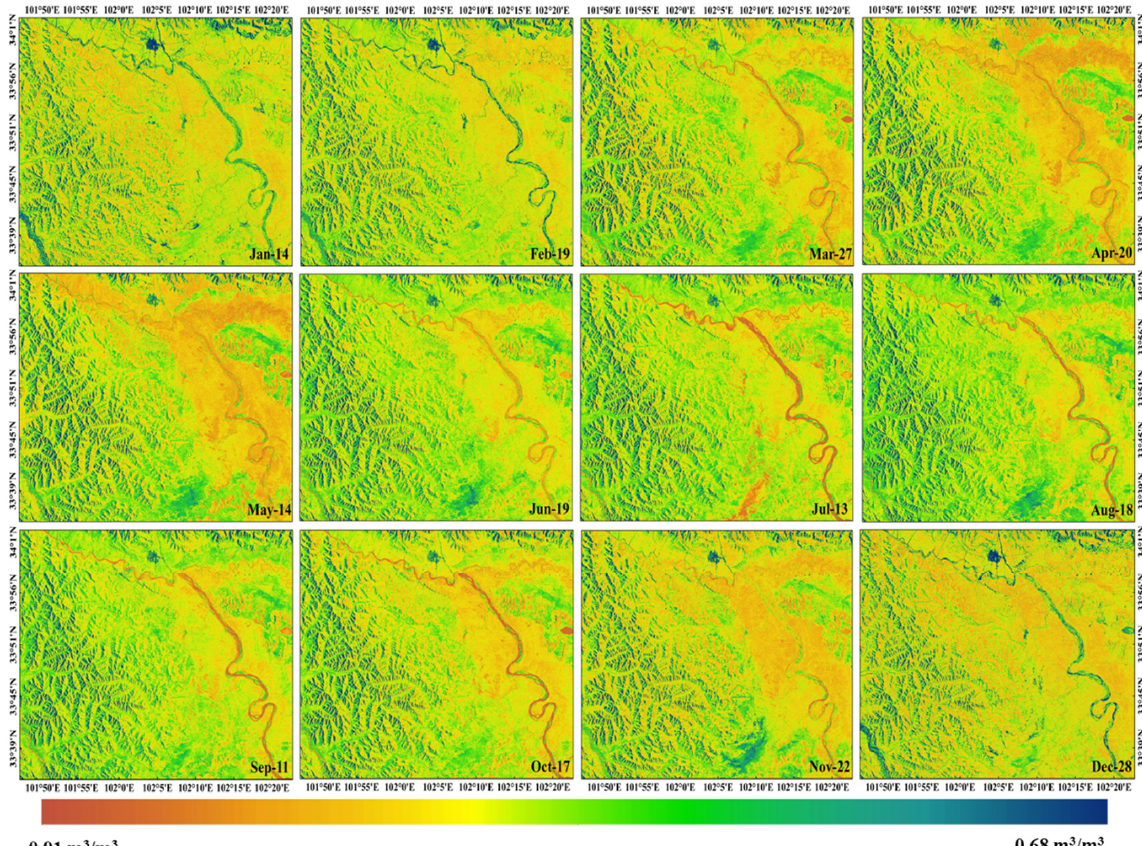
Figure 10. Soil moisture with RF for ascending orbit of Maqu network for 2018.